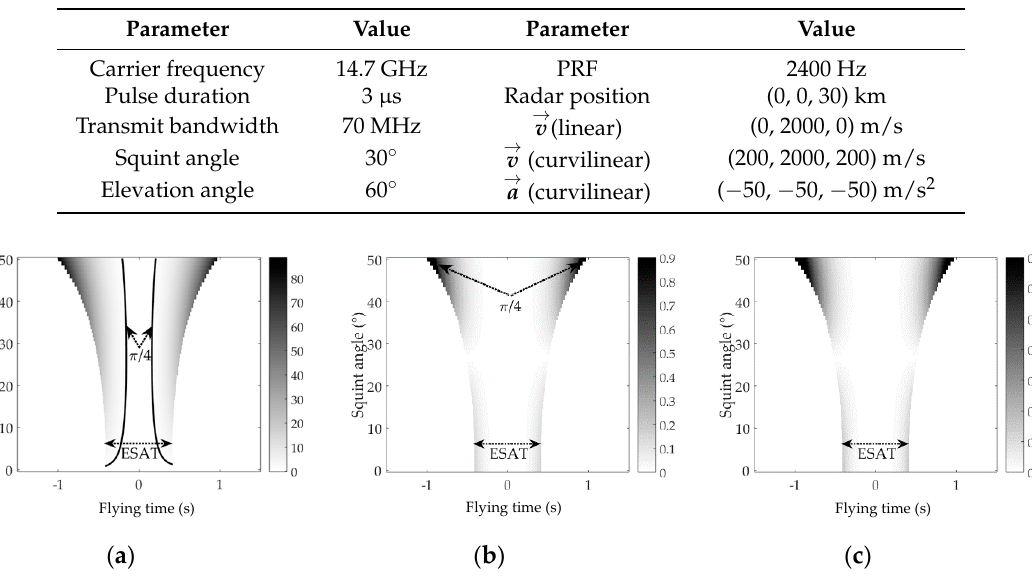
Table 1. Basic simulation parameters.